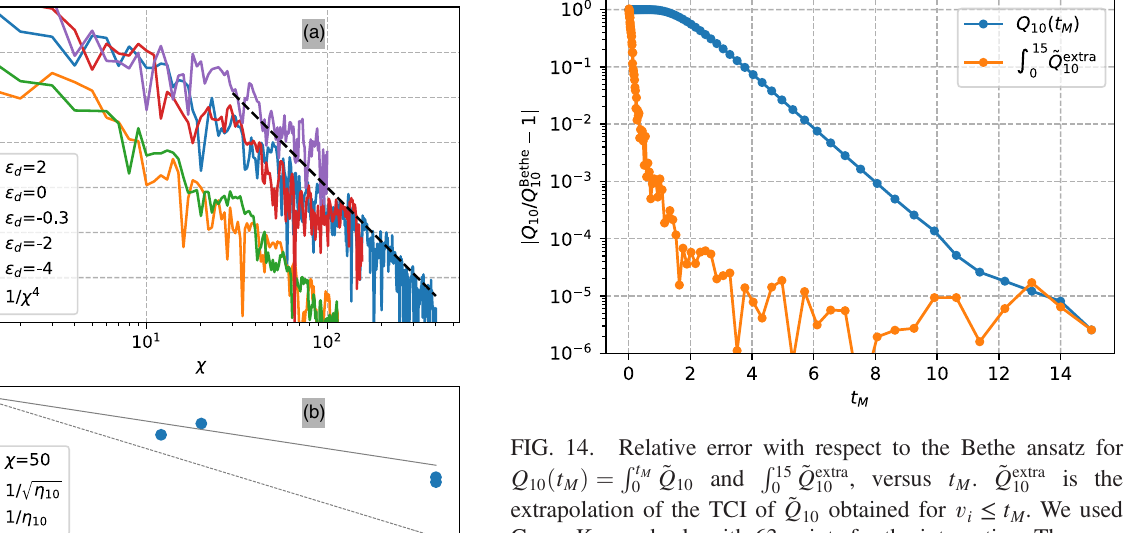
˜ Q extra 10 is the . M ≤ t . We used i M